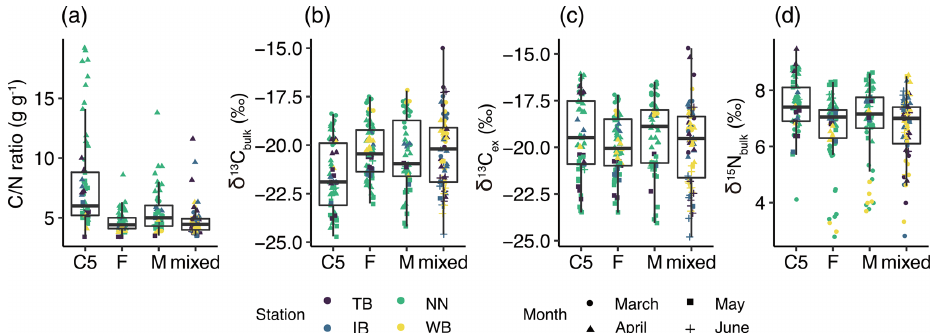
Figure 3. Variations of (a) C / N ratio, (b) δ 13 C bulk , (c) δ 13 C ex , and (b) δ 15 N bulk values in C. sinicus among growth stages and sex. The growth stages and sex of C. sinicus were divided into copepodite V (C5), adult female (F), adult male (M), and mixed (undivided). Box plots show the medians (horizontal lines within boxes), upper and lower quartiles (boxes), and quartile deviations (bars). Small points are raw data points, and the colors and shapes of points indicate stations and sampling months,